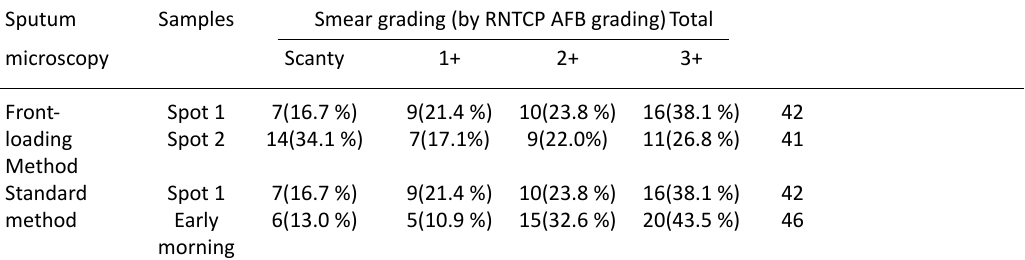
table 2. Grading of AFB positive sputum smears by WHO/IUATLD system